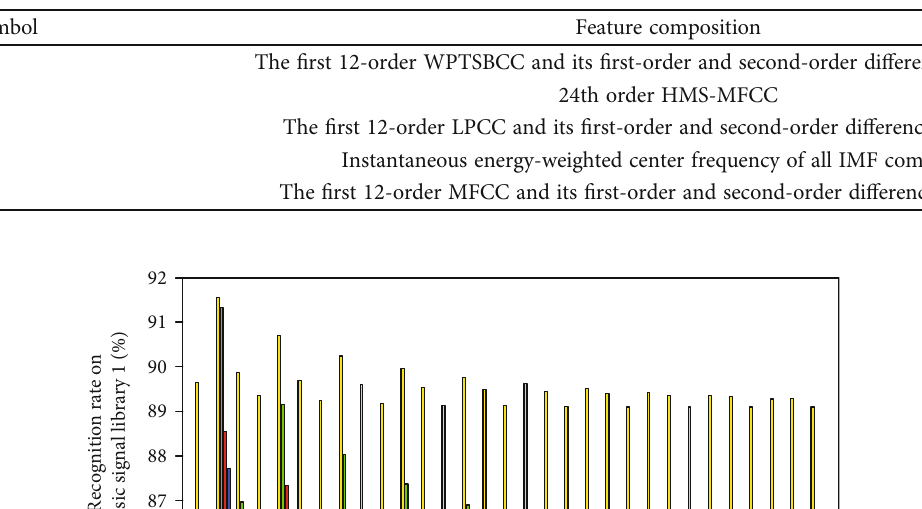
Figure 3: Flow chart of adaptive wave equation inversion. Table 1: Description of characteristic characters.